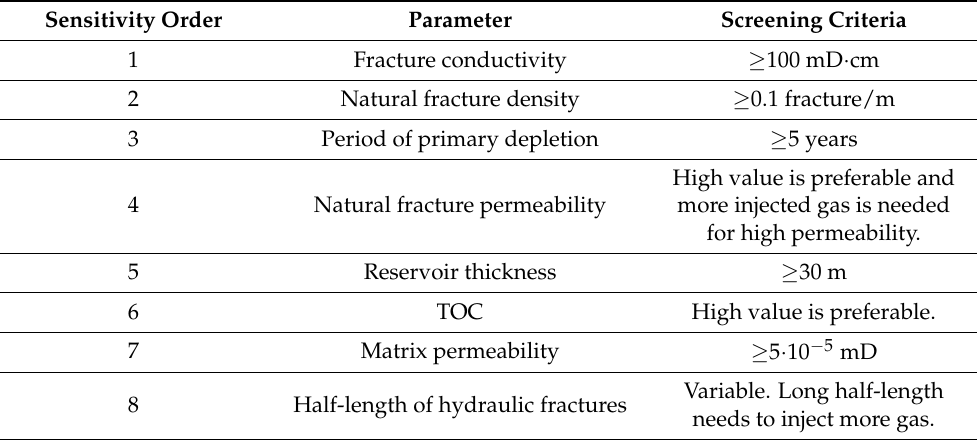
Table 19. Screening criteria for gas huff-n-puff potential area in Duvernay shale volatile oil